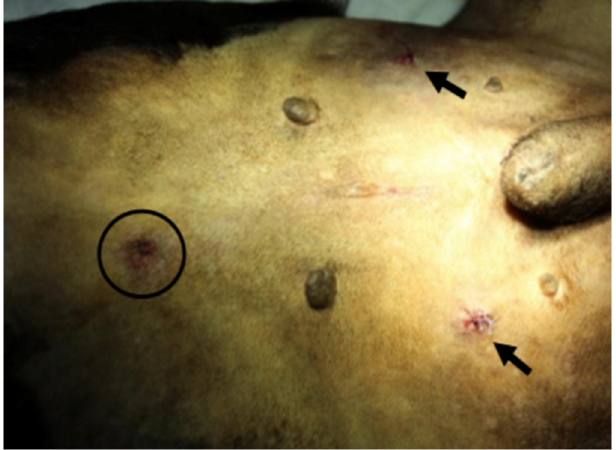
Figure 5. View of the sutures in both trocar sites (arrows) and Veress needle incision (circle).